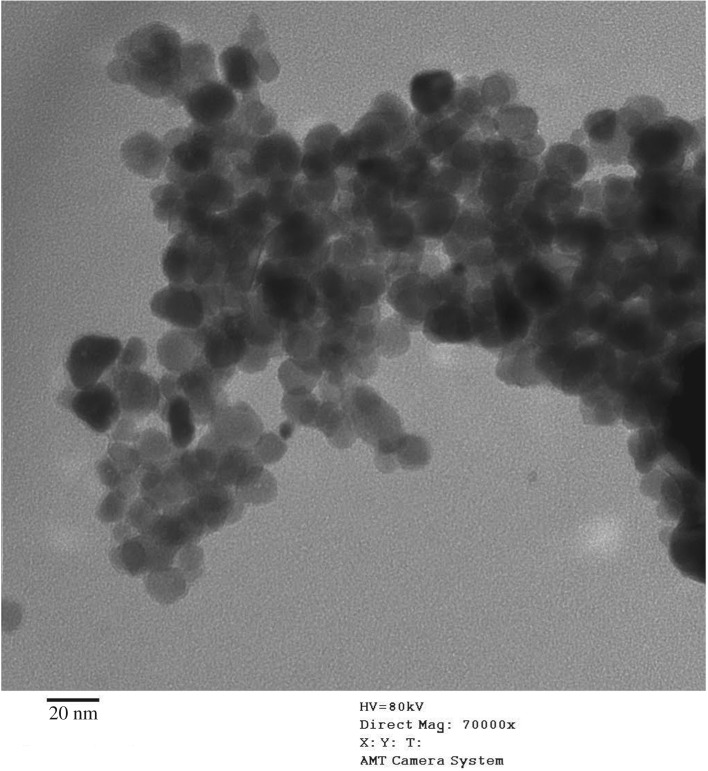
TEM micrograph of the La0.6Sr0.4CoO3 perovskite catalyst.